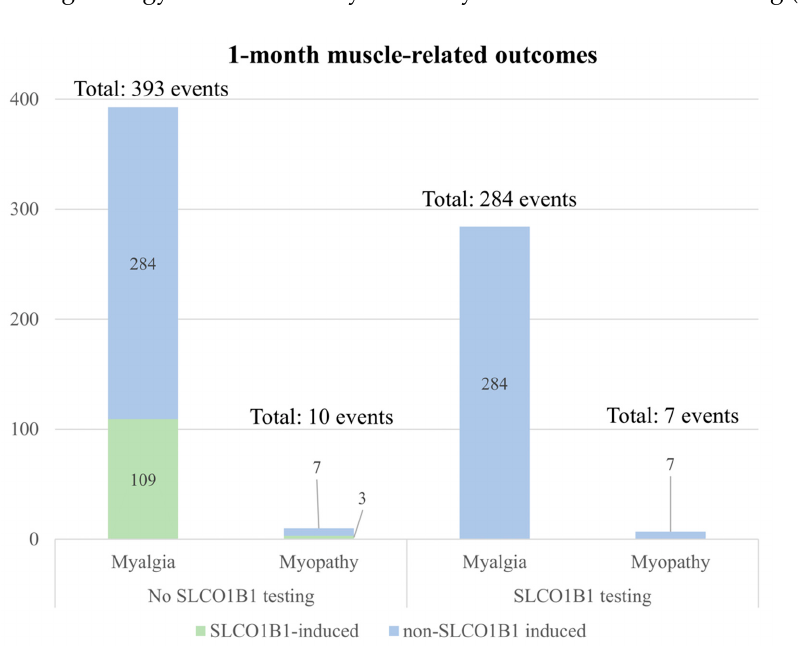
Figure 2. Estimated event outcomes from modeling the best-case scenario. The frequency of 1-month muscle-related outcomes for SLCO1B1 testing and no testing strategies in a hypothetical cohort of 10,000 veteran patients. Outcomes included myalgia and myopathy ( SLCO1B1 -induced and non- SLCO1B1 -induced outcomes).